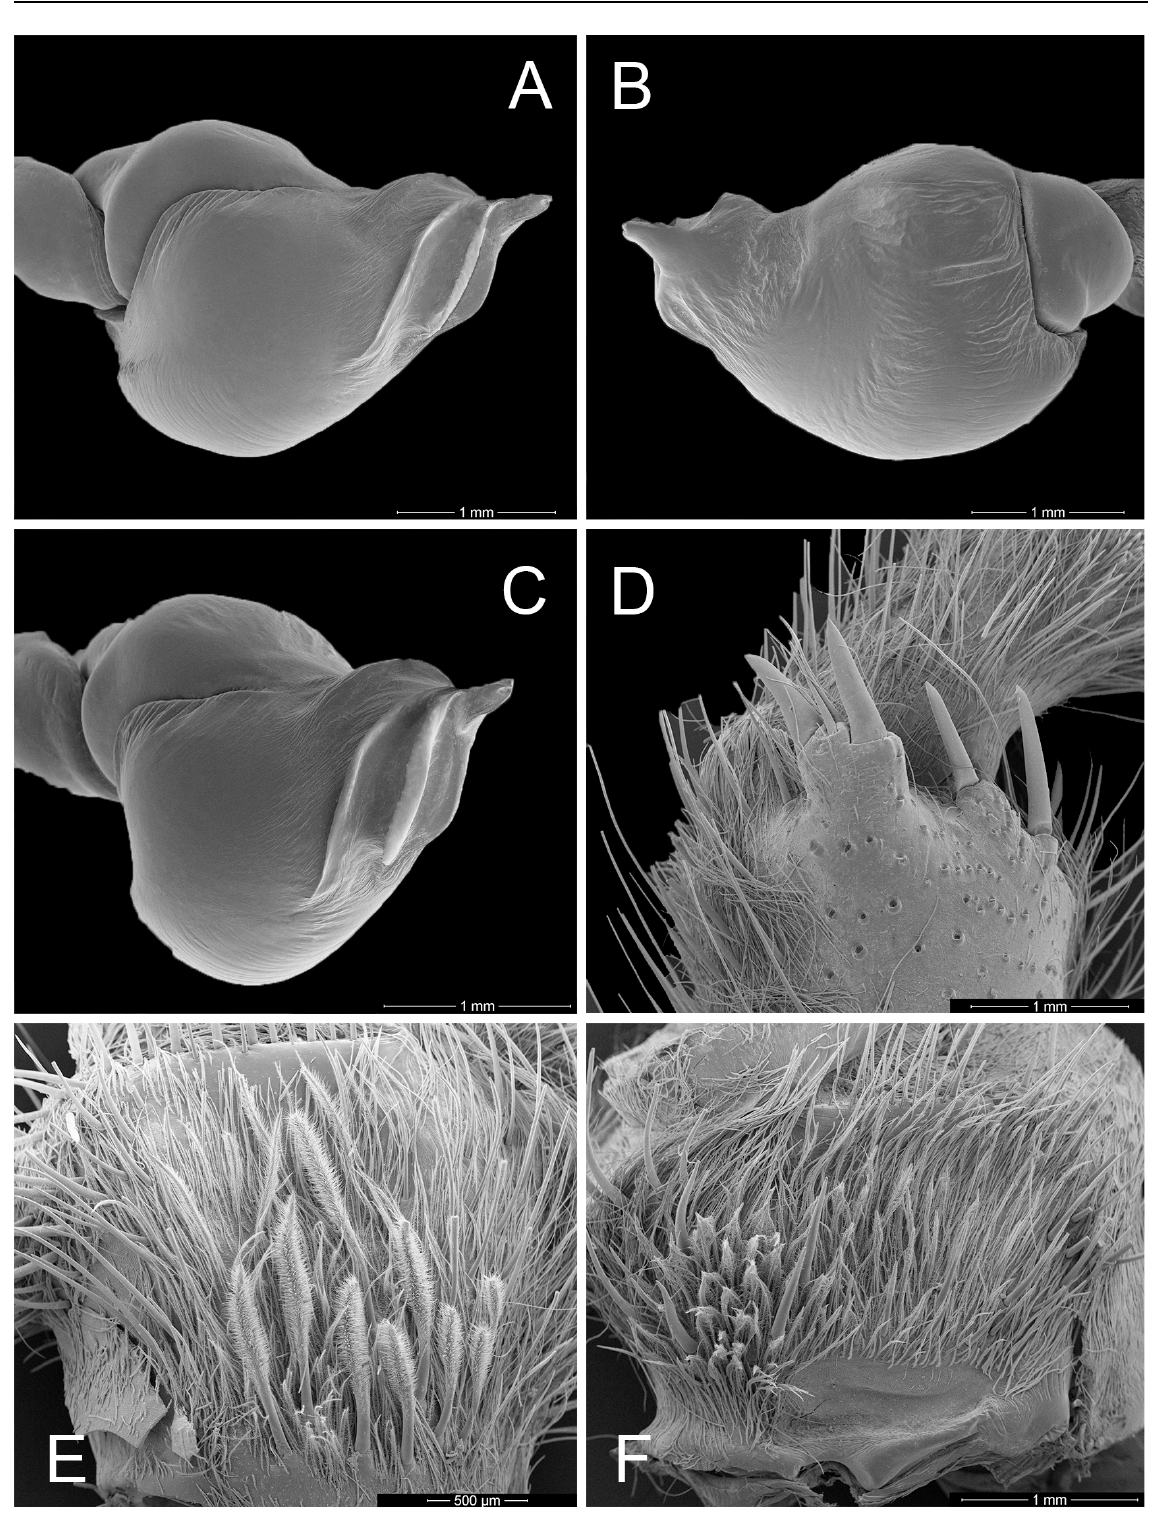
Fig. 24. Umbyquyra tapajos gen. et sp. nov., paratype, ♂, Flona do Tapajós, Belterra, Pará, Brazil (IBSP 161728). A . Palp, prolateral. B . Retrolateral. C . Anterolateral. D . Tibial apophysis, retrolateral. E . Stridulatory organ, trochanter. F . Trochanter